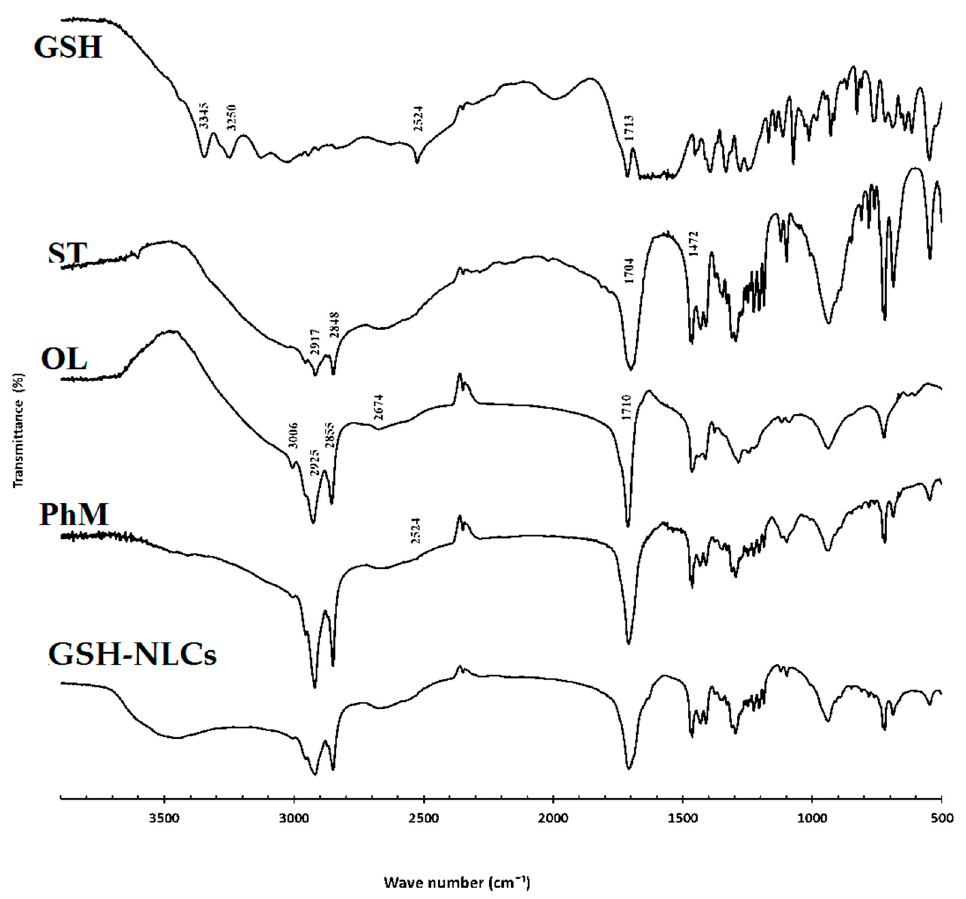
Figure 3. FT-IR spectra of the pure drug (GSH), stearic acid (ST), oleic acid (OL), physical mixture (PhM), and glutathione nanostructure lipid carriers (GSH-NLCs).